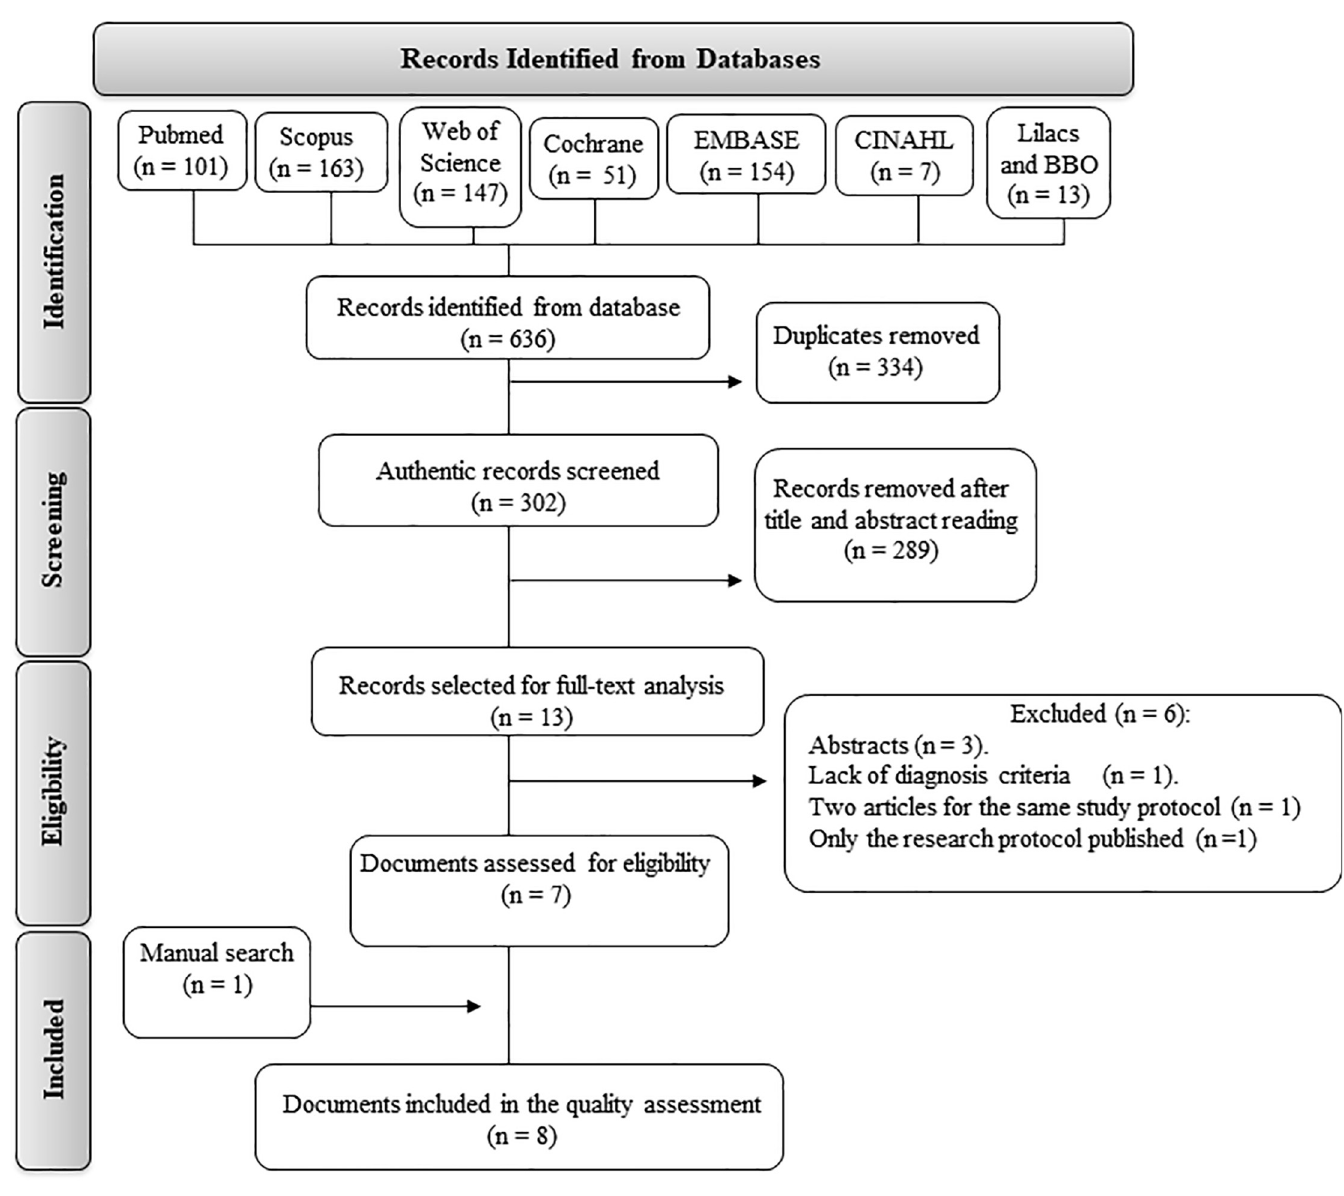
Fig 1. Flow diagram of the search strategy, with the number of studies selected in each database and in each phase of this systematic review.